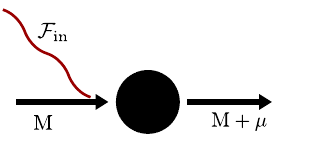
(a) In the classical limit, the change of the black hole only depends on the total